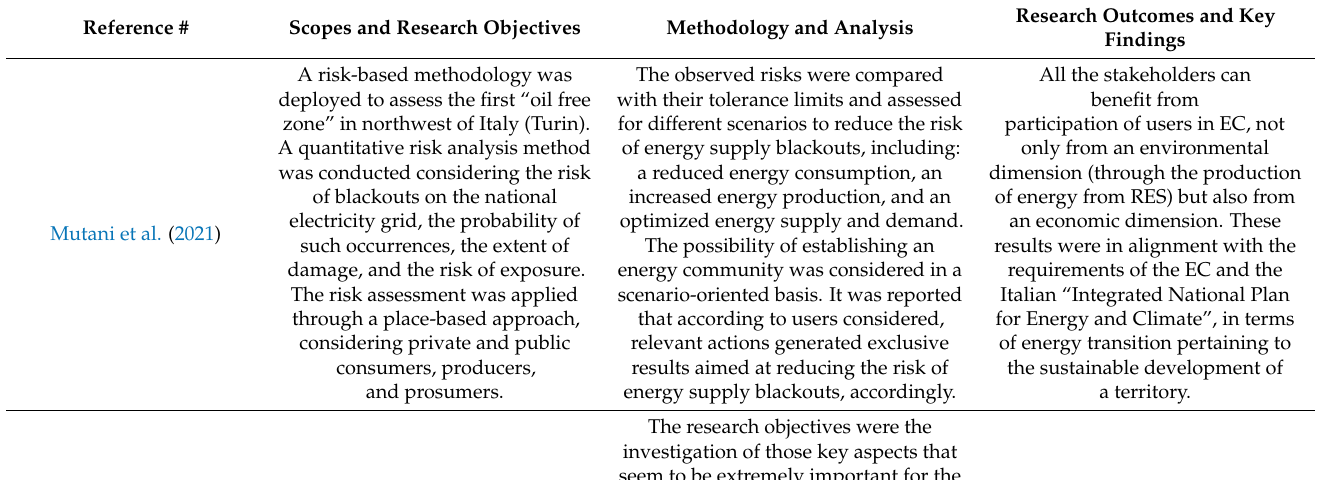
Table 8. The context of security of supply—Group 2 (studies are presented in reverse chronological order and in last name of first author alphabetical